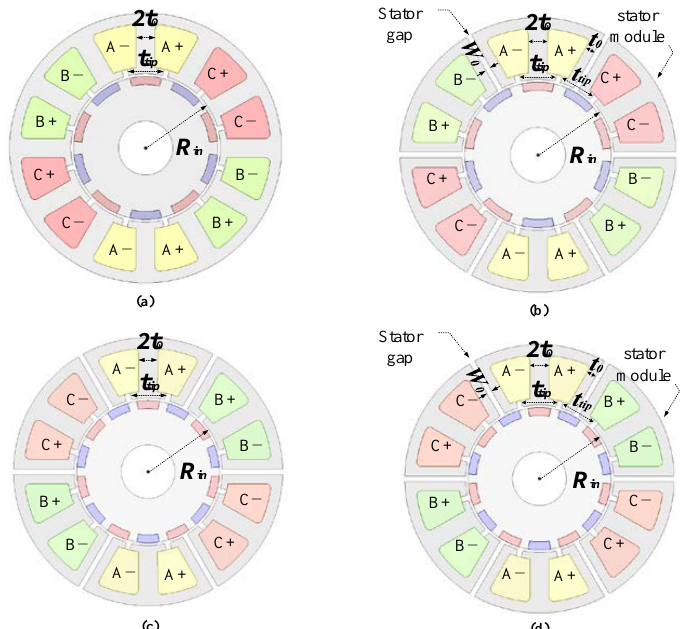
Figure 3. Finite element model of the four machines. ( a ) 12s / 10p integral machine; ( b ) 12s / 10p E-core modular machine; ( c ) 12s / 14p integral machine; ( d ) 12s / 14p E-core modular machine.